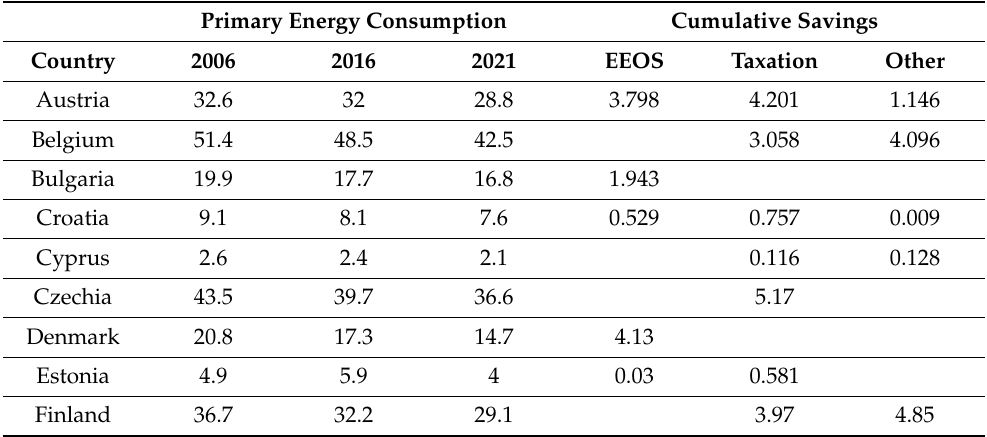
Table 1. Primary energy consumption and cumulative savings according to EED Article